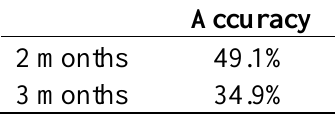
Table 7. Accuracy of 2 and 3 month old chick vocalizations using models trained on 1 month old